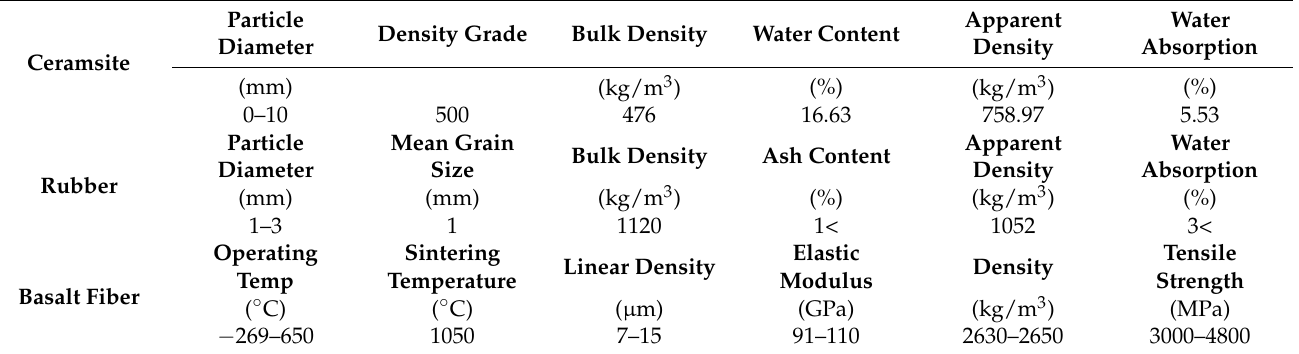
Table 1. Performance parameters of ceramsite, rubber, and basalt